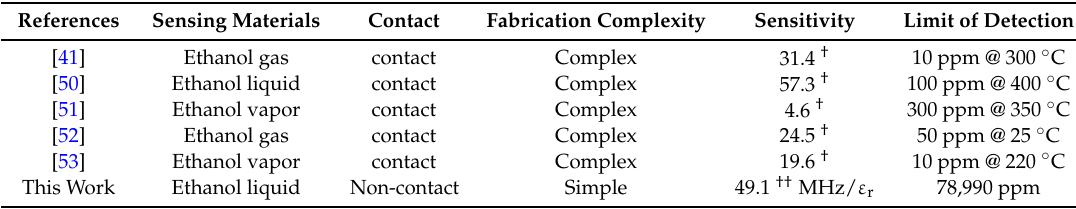
Table 3. Comparison table of proposed sensor and non-RF